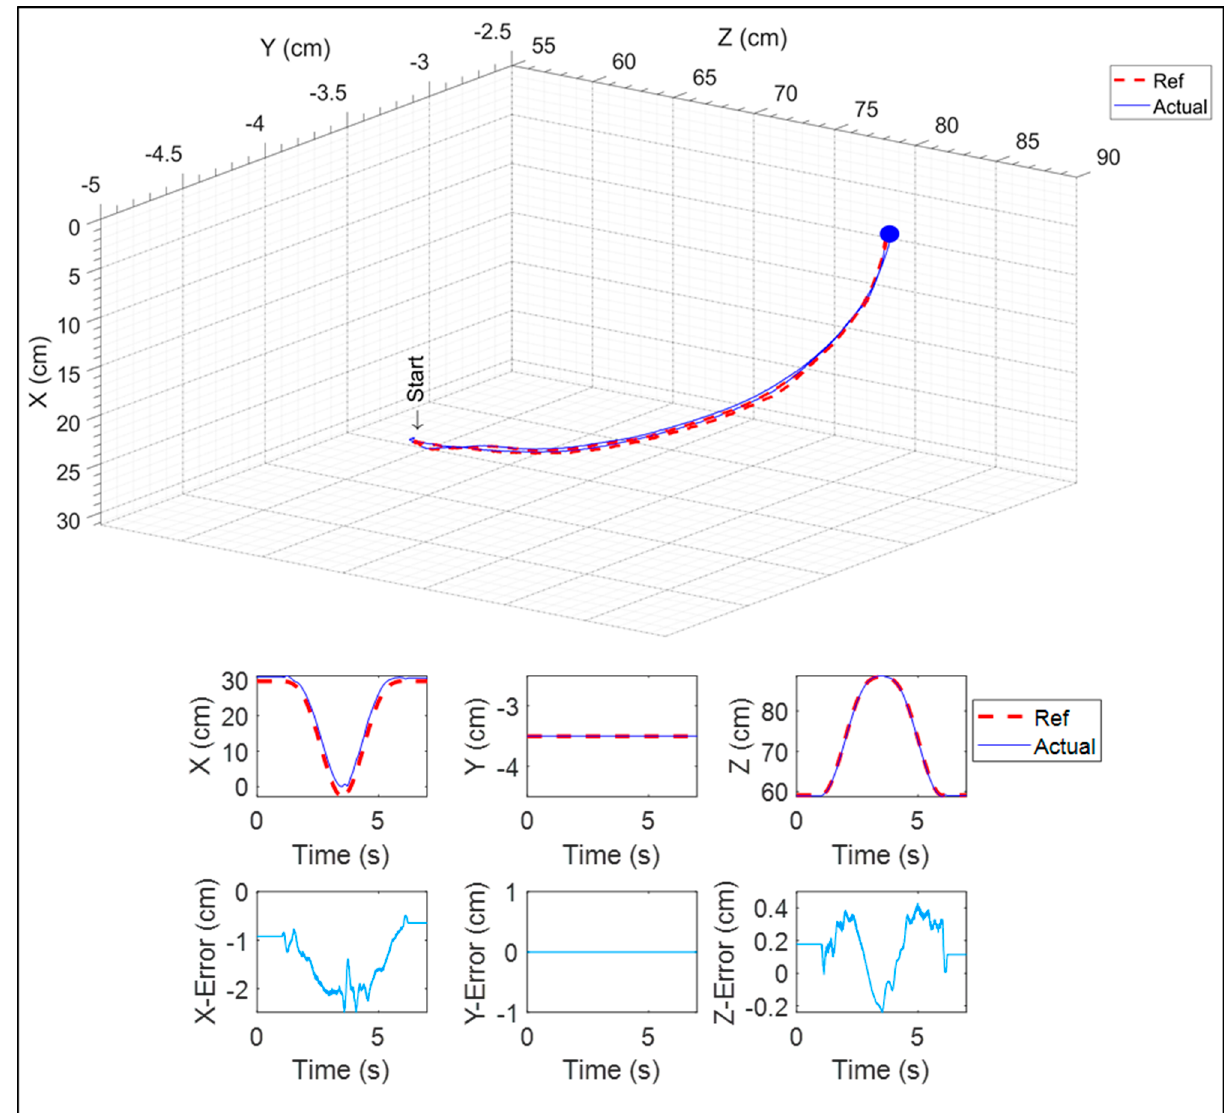
Figure 26. Forward reaching in the sagittal plane.